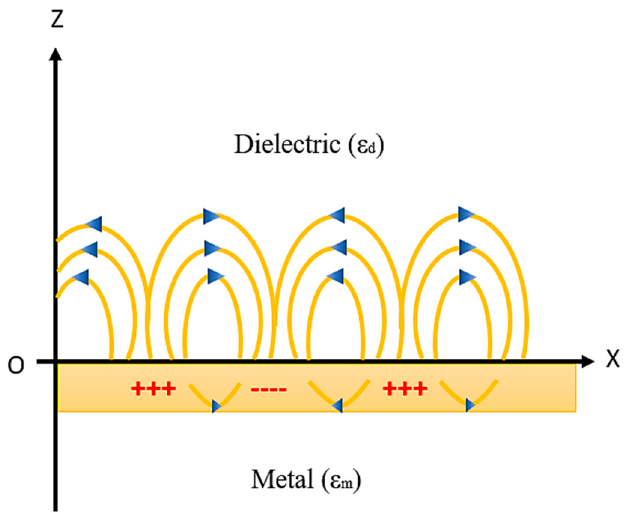
Figure 6. SPW generation at the metal–dielectric interface. Idea adopted from reference [82]. SPWs are longitudinal waves (i.e., p-polarized) generated on the metal–dielectric interface when light passes through the metal. Both the metal and dielectric sample consist of complex RI nm = 2 √ ∈ and n d = 2 d , respectively, as shown in Figure 6. The surface plasmon propagates in parallel to the x direction as an electromagnetic wave with a magnetic field directed in parallel to the y direction, that is, the transvers magnetic polarization (TM)